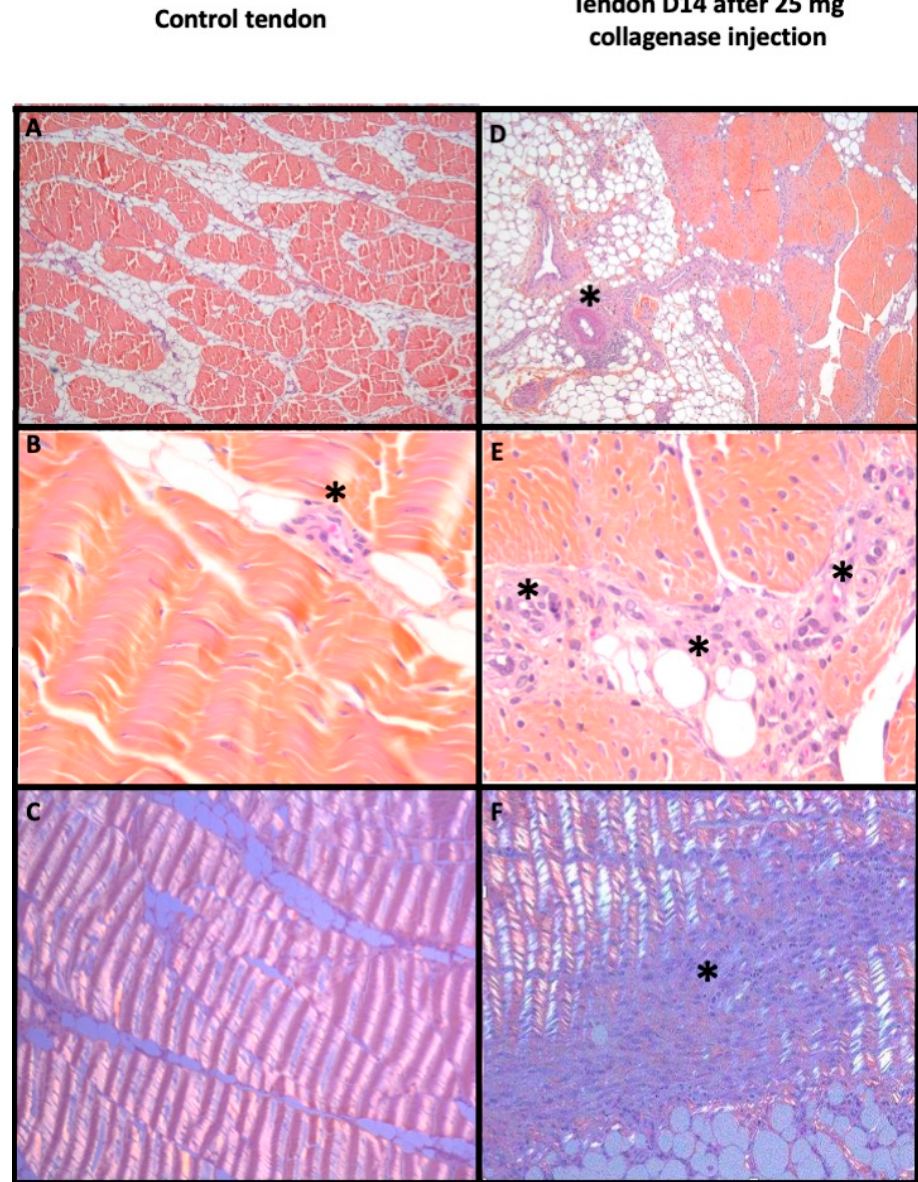
Figure 2. Histological evaluation of a control tendon (left) and a pathological tendon 14 days after injection of 25 mg of collagenase (right). Patellar tendon with HES stain × 50 ( A , D ), × 400 ( B , E ) magnification and × 100 with polarization ( C , F ). In the control tendon, ( A , B ) show regular bundles of small spindle fibroblasts in wavy collagen with few small capillaries between bundles (black asterisk); ( C ) depicted the regular and wavy aspect in polarization. In the pathological patellar tendon, fibrinoid necrosis appeared in peri-tendinous artery (black asterisk) in ( E ) with loss of demarcation of fibers bundles, plump fibroblasts and numerous clusters of capillaries (black asterisk) in ( D ). ( F ) showed focal distortion of wavy appearance in polarization (black asterisk).